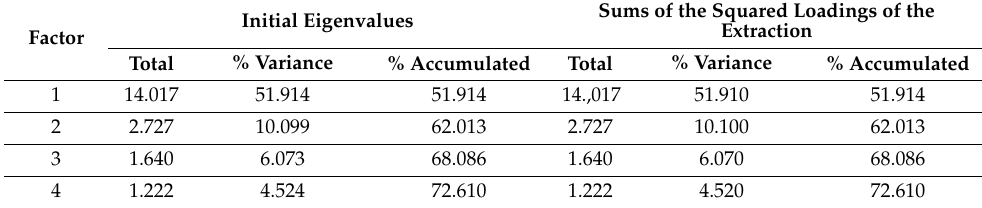
Table 9. Total explained